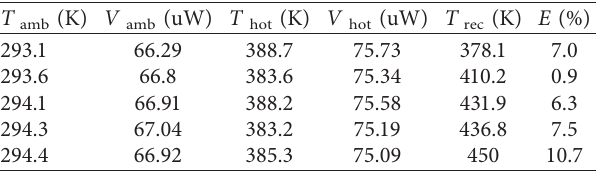
Table 4: Test data and comparison results at 90, 30, and 5 degrees